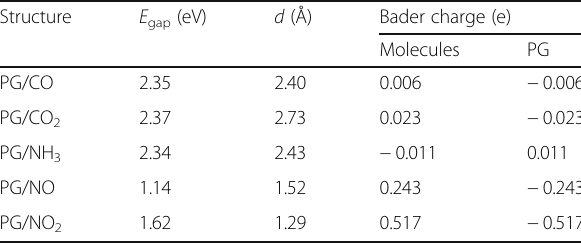
Table 1 The bandgap E gap (eV), interfacial spacing ( d ), and bader charge analysis of optimized PG with gas molecules Structure E gap (eV) d (Å) Bader charge (e)